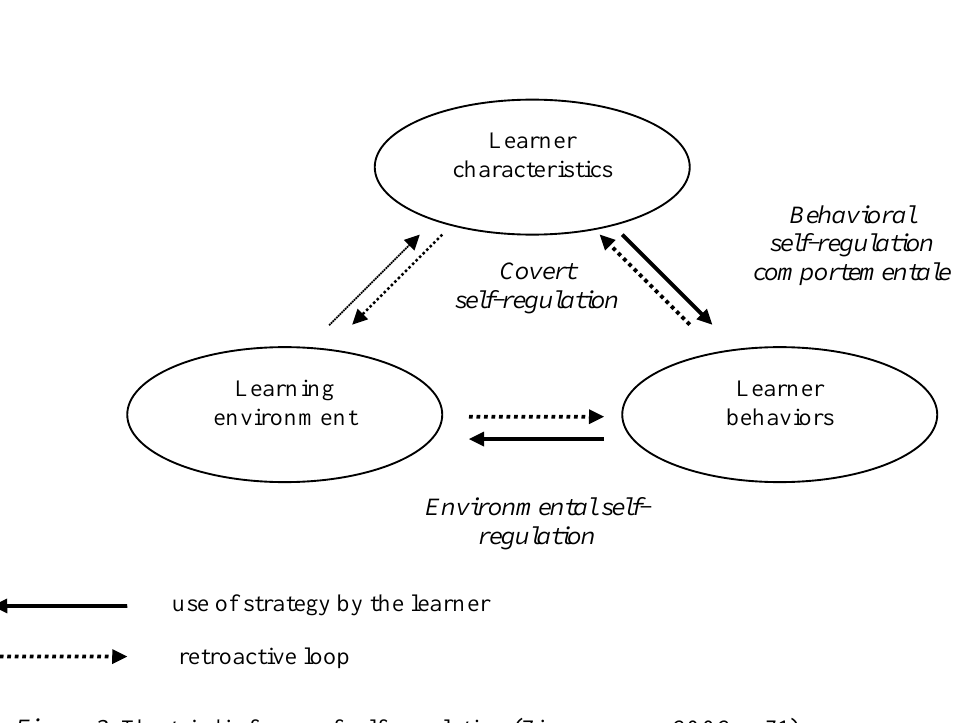
Figure 3 . The triadic forms of self-regulation (Zimmerman, 2002,